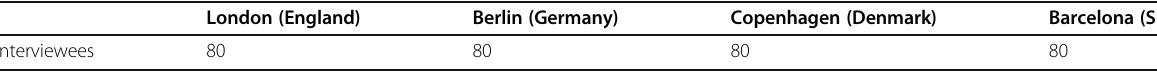
Table 9 Information about the respondents to the